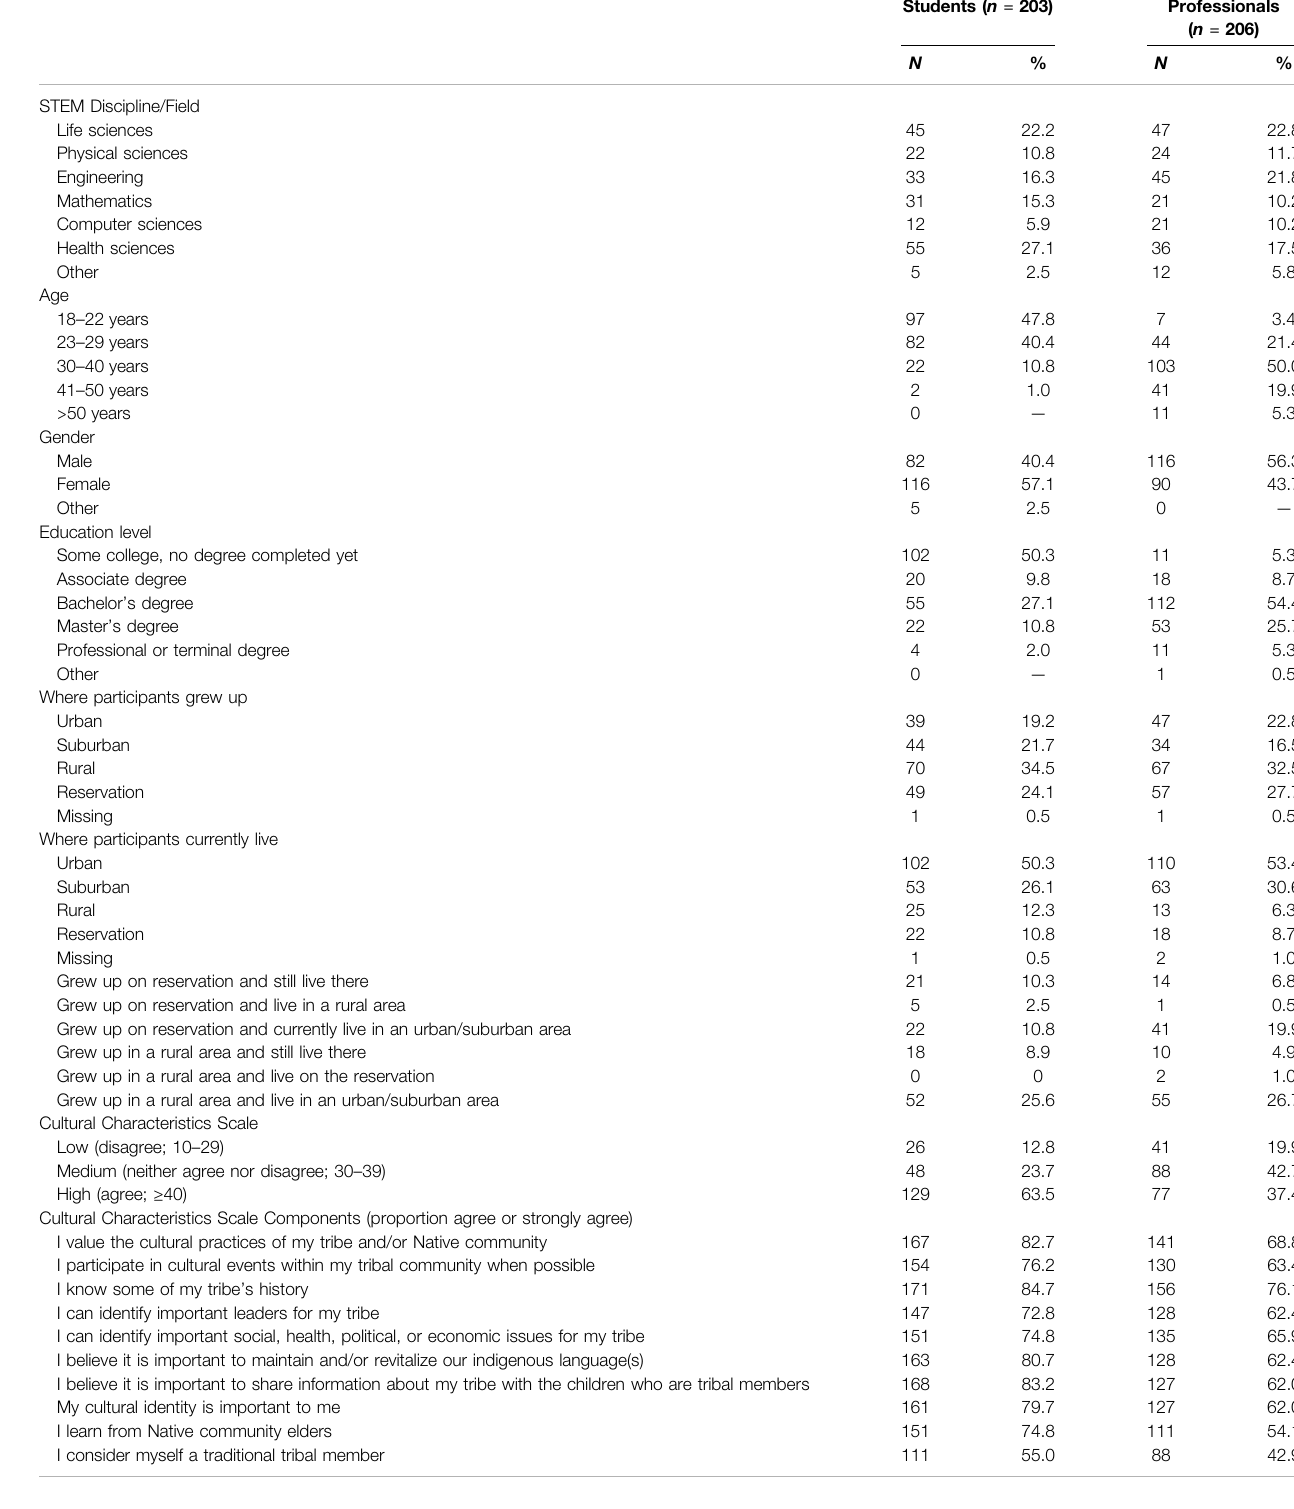
TABLE 1 | Descriptive characteristics among STEM students and